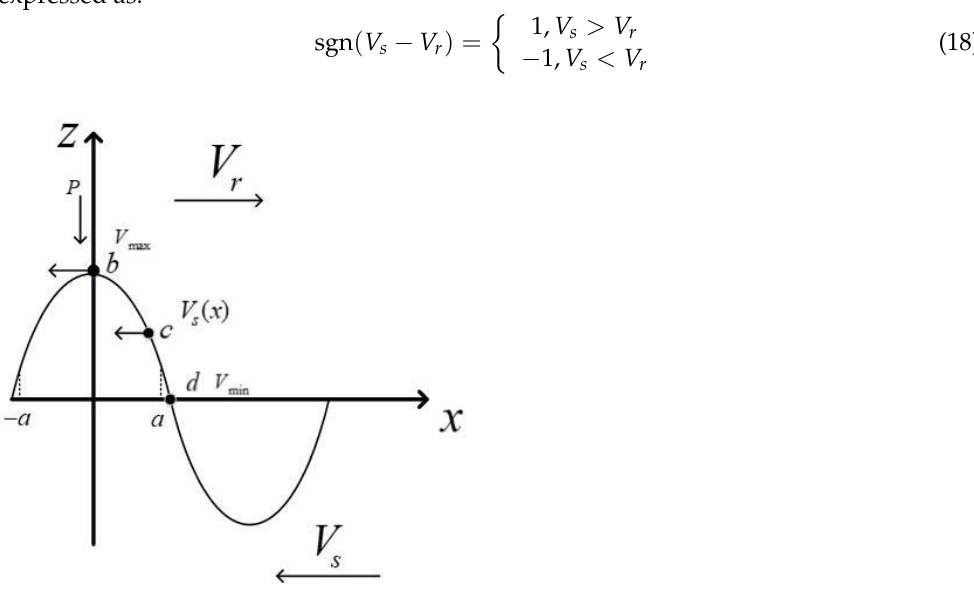
Figure 5. Schematic diagram of the velocity of the mass point on the stator superficies at different contact positions.